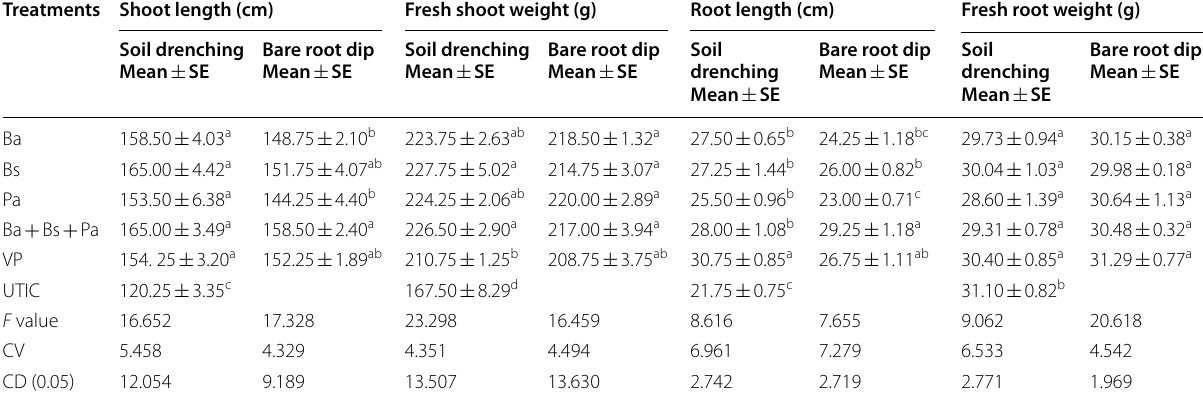
Data shown correspond to the mean of four replicates SE. Means with the same alphabet letters on each columns are not significantly ( P < 0.05 ) different ± CD critical difference, CV coefficient of variation, SE standard error. Treatment details: Ba Bacillus amyloliquefaciens DSBA 11; Bs Bacillus subtilis DTBS 5, Pa Pantoea agglomerans ; Ba Bs Pa (Consortium), UTIC Untreated nematode inoculated control, VP Velum Prime ® (500 g a.i./ha) as positive control + +